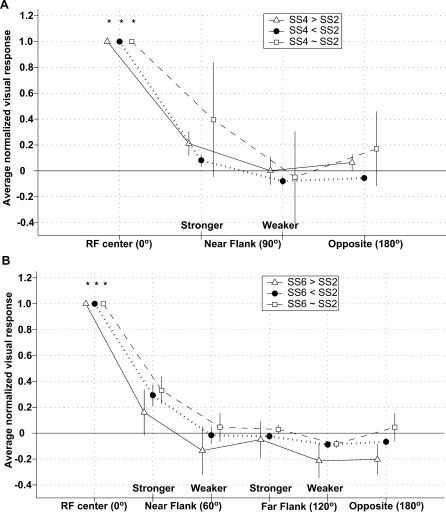
Receptive Field Profiles for Neurons with and without Set-Size Effects(A) Each point shows the normalized visual response (average ± standard deviation) on the memory-guided saccade task at the locations tested with set-size 4 for neurons with different effects of set size. Responses from locations equidistant from the RF center were pooled according to their relative response magnitude (i.e., the location eliciting the stronger or weaker response) regardless of whether they were displaced clockwise or counterclockwise from the RF center. Stars indicate p < 0.05 relative to 0.(B) Same as (A) but for set-size 6.